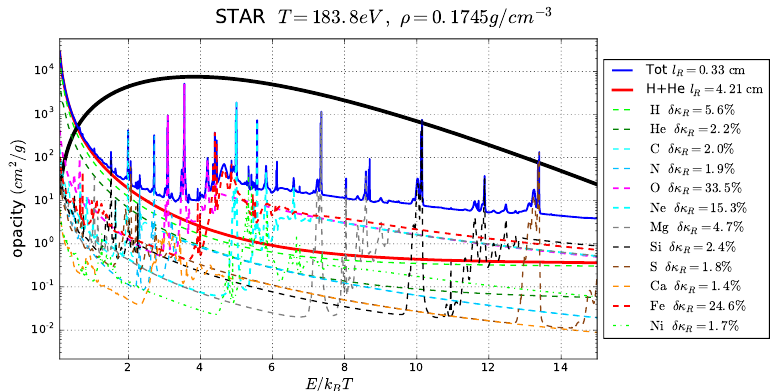
Figure 4. The opacity spectrum for the solar mixture at the conditions found at R = 0.715 R (cid:12) (near the solar convection-zone) where T = 183.8 eV and ρ = 0.1745 g/cm 3 . The total opacity due to all element in the solar mixture (solid blue) is compared to the opacity due to hydrogen and helium only (solid red), and the spectra of various individual elements, with a Rosseland opacity contribution that is larger than 1% (dashed lines). The Rosseland mean free path l R and the Rosseland opacity contributions δκ R , are listed in the legend. The Rosseland weight function (solid black) is also shown.